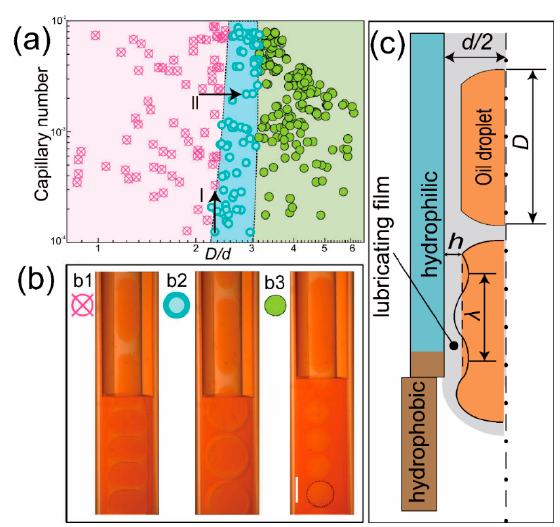
Figure 2. High-viscosity microspheres obtain by the phase-inversion method. ( a ) Log–log phase diagram of droplets inside the microfluidic chip. ( b1 ) Low-in-high-viscosity droplets go through the orifice; ( b2 ) Every two low-in-high-viscosity droplets break at the orifice every and form double emulsion droplets; ( b3 ) Every low-in-high droplets break at the orifice and form single emulsion droplets. The scale bar is 500 μ m; ( c ) Schematic illustration of the formation of high-viscosity droplets due to the breakup of the lubricating film.